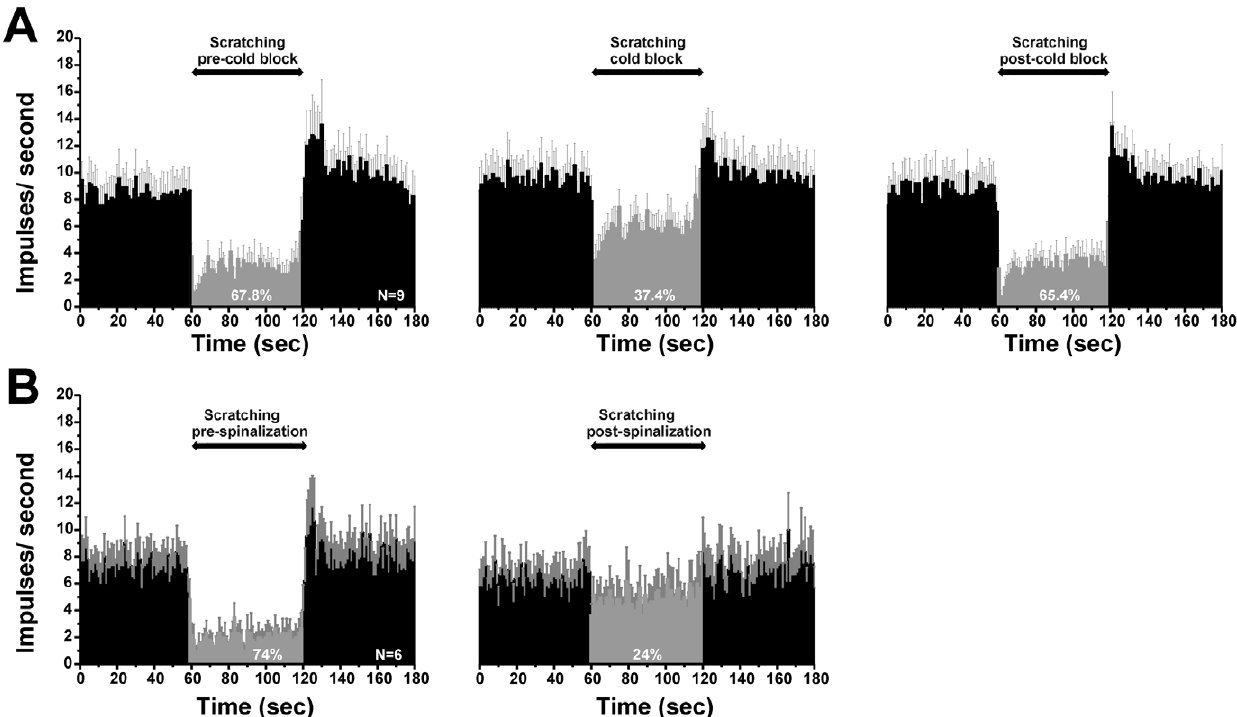
Figure 6. Disruption of upper cervical spinal cord reduces scratch-evoked inhibition. A: cold block. Left-hand PSTH shows averaged firing of 9 units before and during scratching under control conditions. Middle PSTH shows reduction in the degree of scratch-evoked inhibition during cold-block of upper cervical cord. Right-hand PSTH shows recovery of scratch-evoked inhibition after rewarming the cervical cord. B: Spinalization. Shown are mean PSTHs of 6 units from separate animals, before (lefthand PSTH) and after (right-hand PSTH) complete transection of the upper cervical spinal cord.